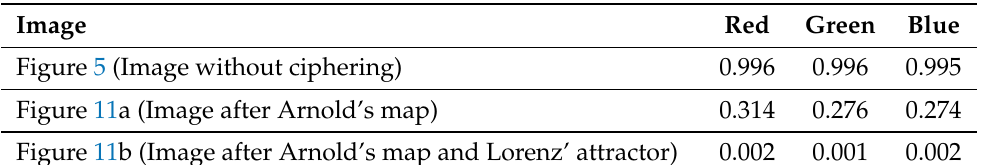
Table 2. Correlation values for Red, Green, and Blue channels for different images in the encryp- tion process.